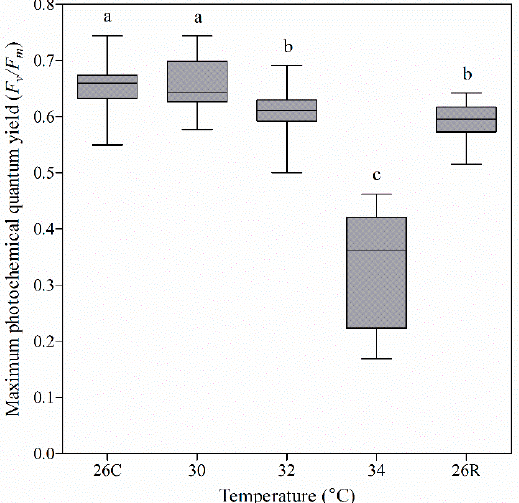
Figure 3. Determination of the maximum photochemical quantum yield ( F v / F m ) of Pocillopora sp. at different temperatures (means ± SEs). The coordinates 26C and 26R represent the 26 ◦ C control and 26 ◦ C recovery, respectively. Five biological samples ( n = 5) were collected at the last moment of each temperature gradient for F v / F m determination. Each sample was randomly measured eight difference; different letters: significant difference, p <